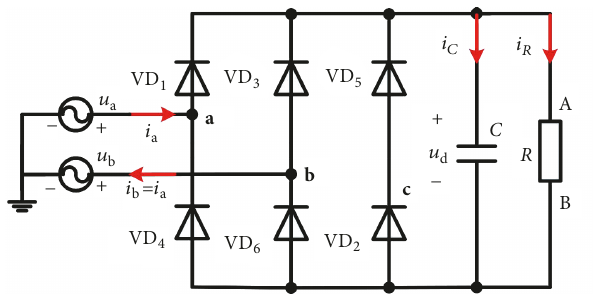
Figure17:Three-phasebridgerectifiercircuitrunningundersingle- phase open circuit